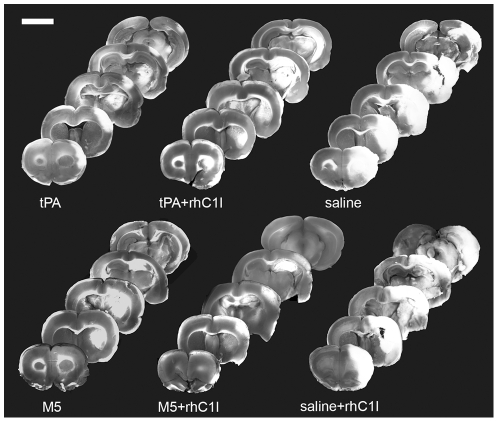
(Part II): Brain infarct zones from representative rats in each group.Five antero-posterior TTC stained 2 mm-thick coronal sections from a representative animal from each group. Infarct areas in cerebral cortex, hippocampus and striatum appear white. The least amounts of infarction were with tPA, M5, and M5+rhC1I. Scale bar: 5 mm.